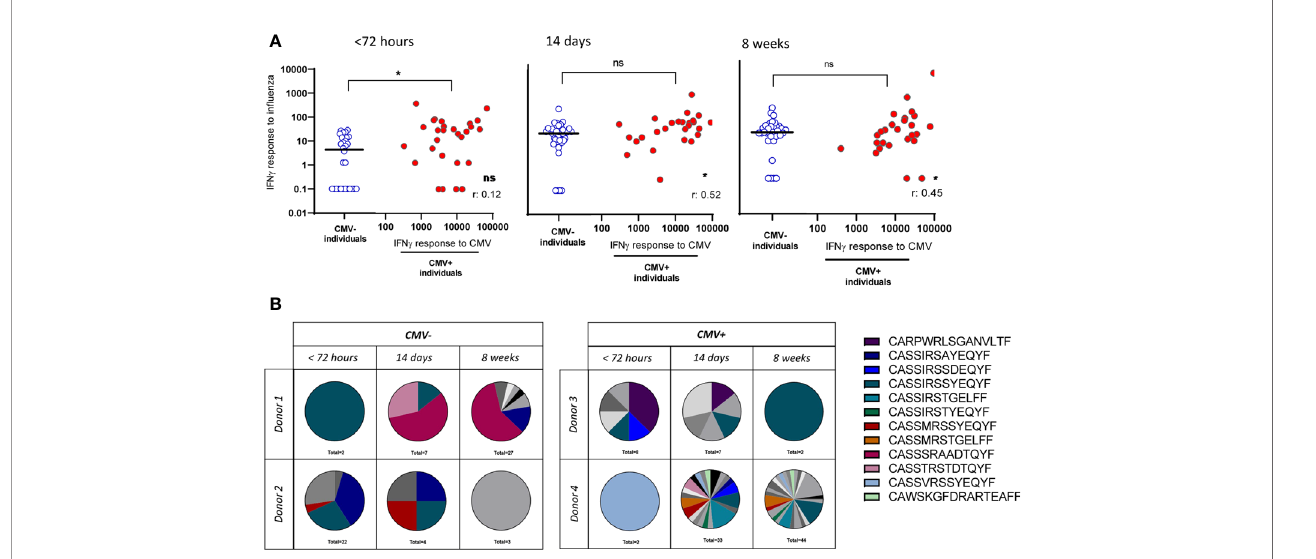
FIGURE 3 | No reduced IAV-speci fi c T-cell response in number of T cells or clonal diversity due to large expansions of CMV-speci fi c T cells. (A) IAV-speci fi c IFN g T- cell response in CMV - and CMV + individuals differentiated on the CMV-speci fi c T-cell response. IAV-speci fi c IFN g T-cell responses are depicted in blue open circles in scatter plot for CMV - individuals and in red solid circles in correlation of CMV-speci fi c IFN g T-cell responses for CMV + individuals. Differences were tested using Mann-Whitney to compare CMV + and CMV - individuals. Correlation between CMV-speci fi c T-cell responses and IFN g response to in fl uenza was tested by Spearman correlation. T-cell IFN g responses are presented per 1 x 10 6 PBMCs. (B) T-cell repertoire of sorted HLA-A2-GILG – speci fi c CD8 + T cells, detected by PCR of two CMV - and two CMV + individuals. Each pie-chart depicts the repertoire of a donor at a certain timepoint (< 72hours, 14 days or 8 weeks after infection). Colors represent shared CDR3 sequences between timepoints and donors. Grey scales depict unique CDR3 sequences. *P < 0.05. ns, non signi fi